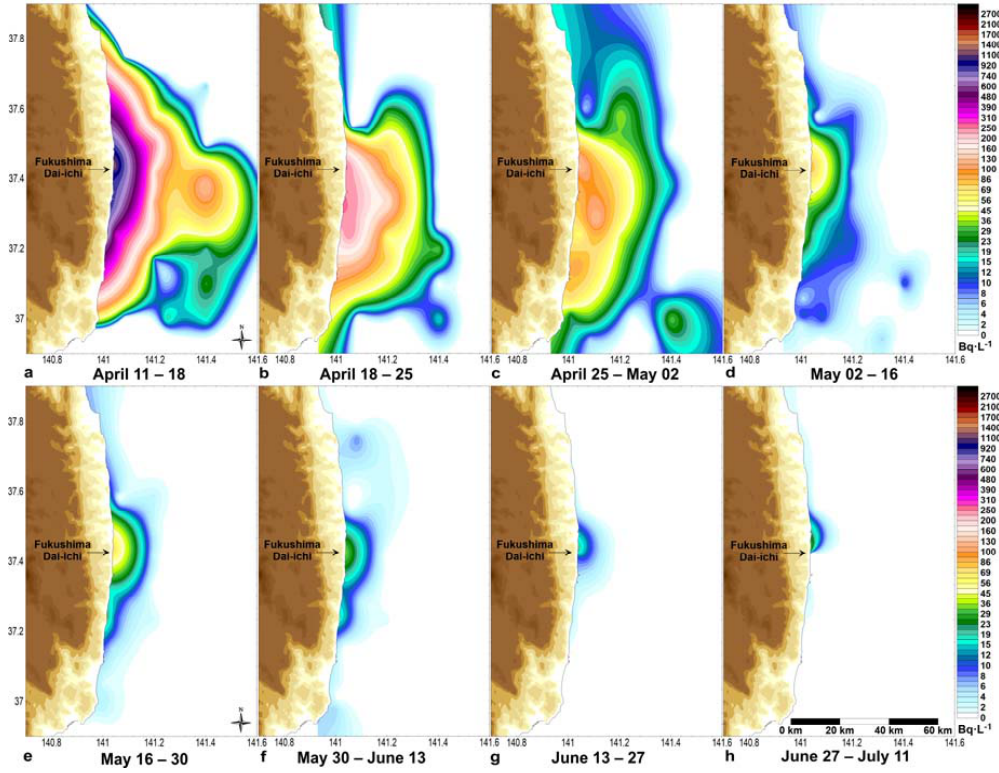
Figure 19. Concentrations of 137 Cs in seawater between 11 April and 11 July 2011, adapted from [59].